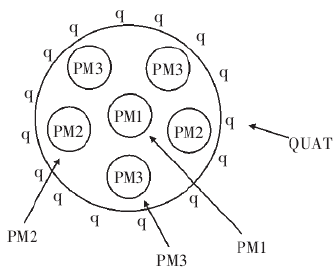
Figure 11. Nozzles arrangement of DLN-2.6 burners.